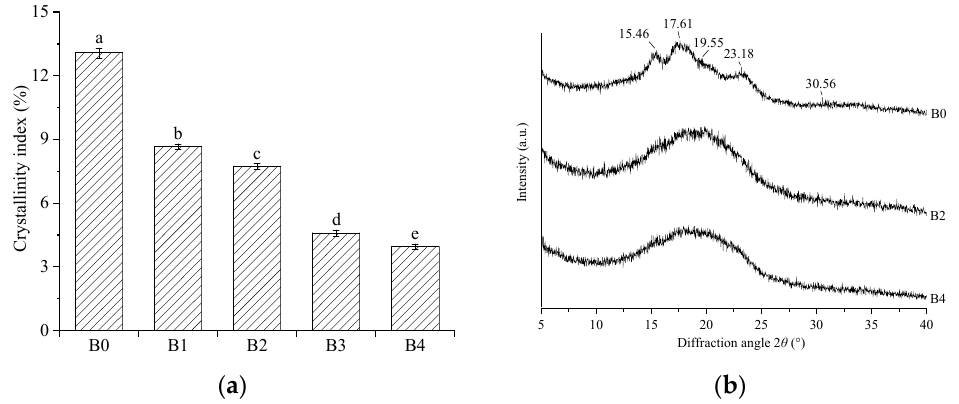
Figure 3. Crystallinity index ( a ), X-ray diffraction pattern ( b ), and the wheat bran. The B0, B1, B2, B3, and B4 are the wheat bran prepared under the rolling frequencies 0, 6, 9, 12, and 15 times. Different lowercase letters on the shoulders of the column indicate significant differences ( p < 0.05).